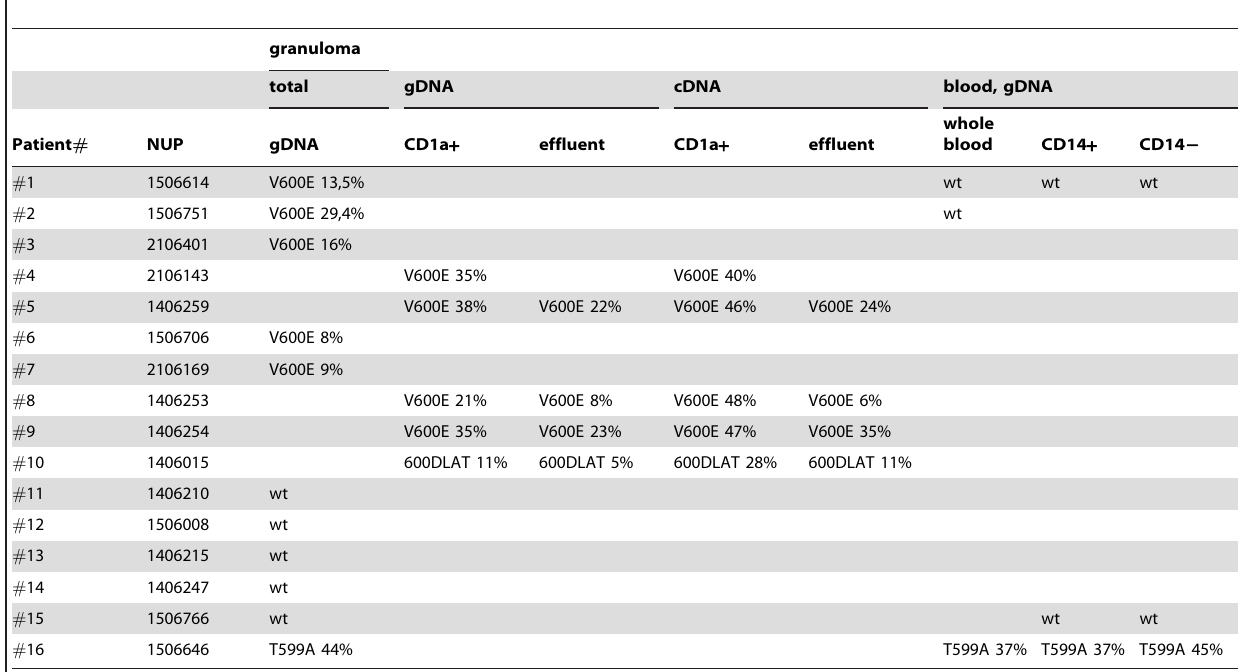
Table 2. Presence and relative abundance of B-RAF mutant clones identified in granuloma and blood from patients with LCH.